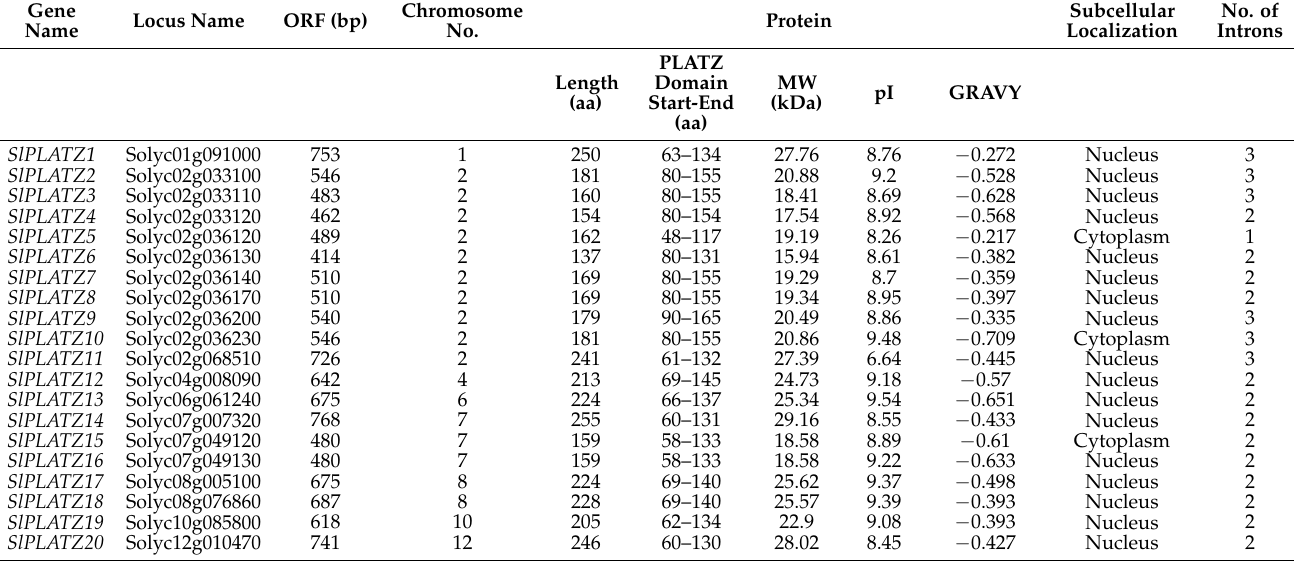
Table 1. In silico analysis of PLATZ genes and their corresponding proteins in